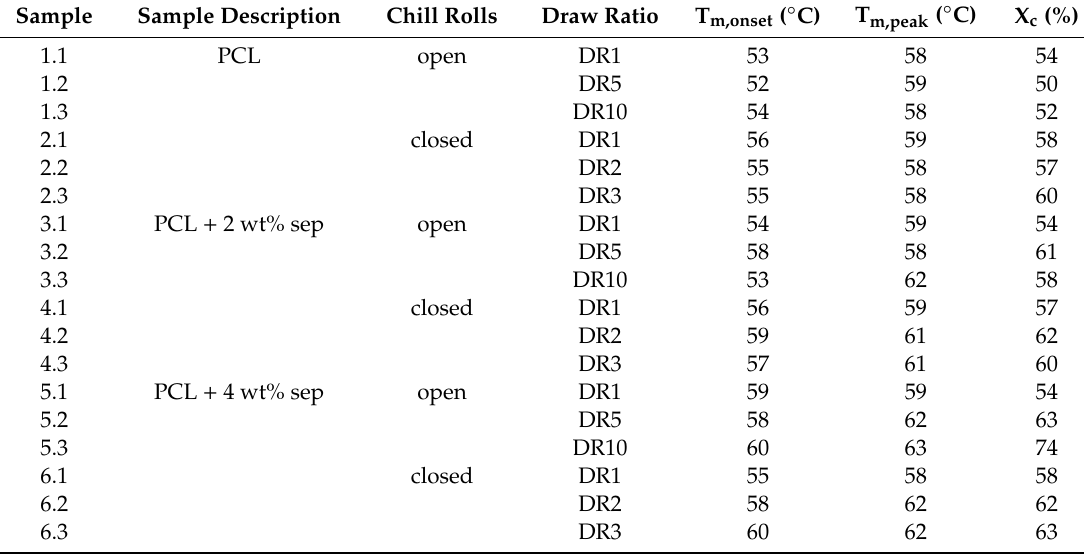
Table A3. Overview of thermal properties of the di ff erent undrawn and drawn samples. The values are calculated from the first heating curve of the DSC